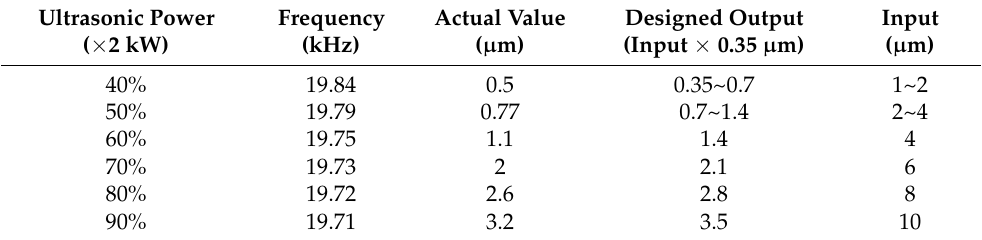
Figure 2. Performance test of the stepped horn: ( a ) actual resonance frequency; ( b ) actual vibration amplitude detection. Table 1. The actual values compared with designed value under different powers.